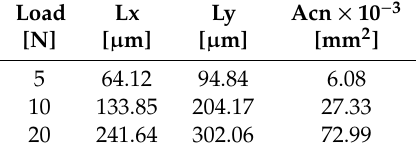
Table 6. Averaged scratch bond test results of the Al 2 O 3 -15 wt.% TiO 2 / NiAl / Al-Si coating system.